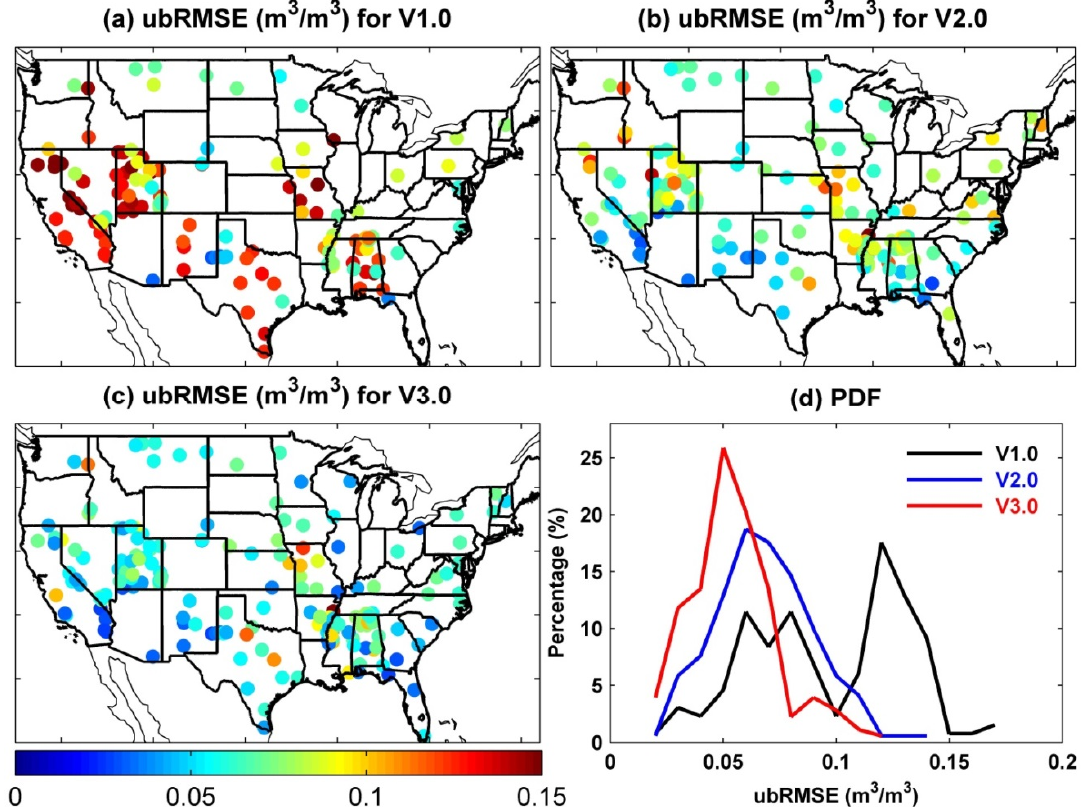
Figure 5. With respect to the quality controlled SCAN observations, unbiased root mean square errors ( ubRMSE s in m 3 /m 3 unit) for ( a ) SMOPS version 1.0 over the 1 June 2007–3 November 2011 period, ( b ) SMOPS version 2.0 over the 16 November 2011–20 September 2016 period, ( c ) SMOPS version 3.0 over the 1 April 2015–31 December 2019 period, as well as ( d ) CONUS domain-averaged frequency probability as a function of RMSE for the three versions SMOPS blended soil moisture data products during the corresponding product time periods with curves shifting toward the left (right) indicating lower (greater) errors.